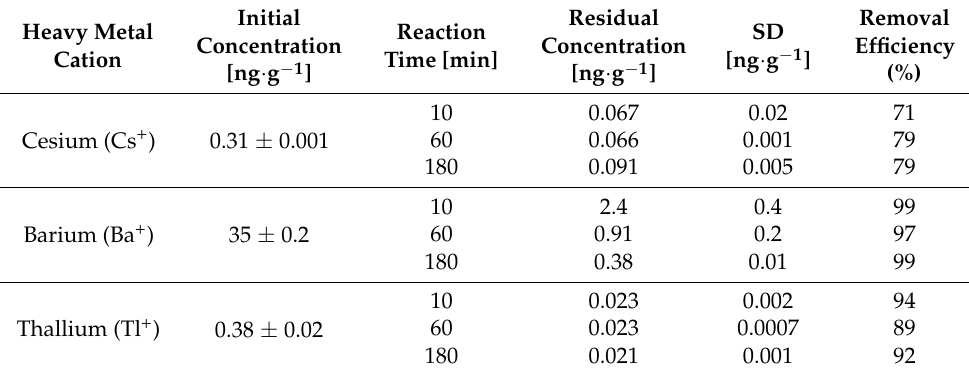
Table 12. Adsorption kinetics of different heavy metal cations for the PCT in non-contaminated non-carbonated mineral water.